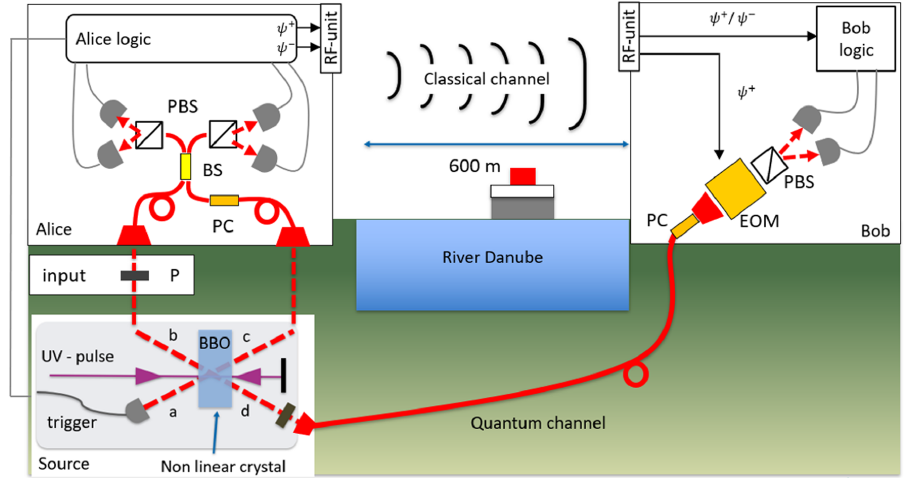
FIG. 4. Set up of teleportation experiment (redrawn by Ref.